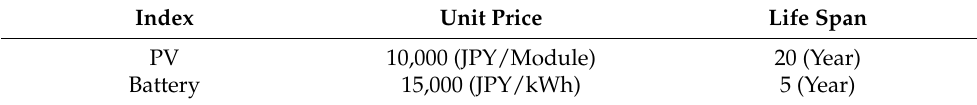
Table 1. Price of